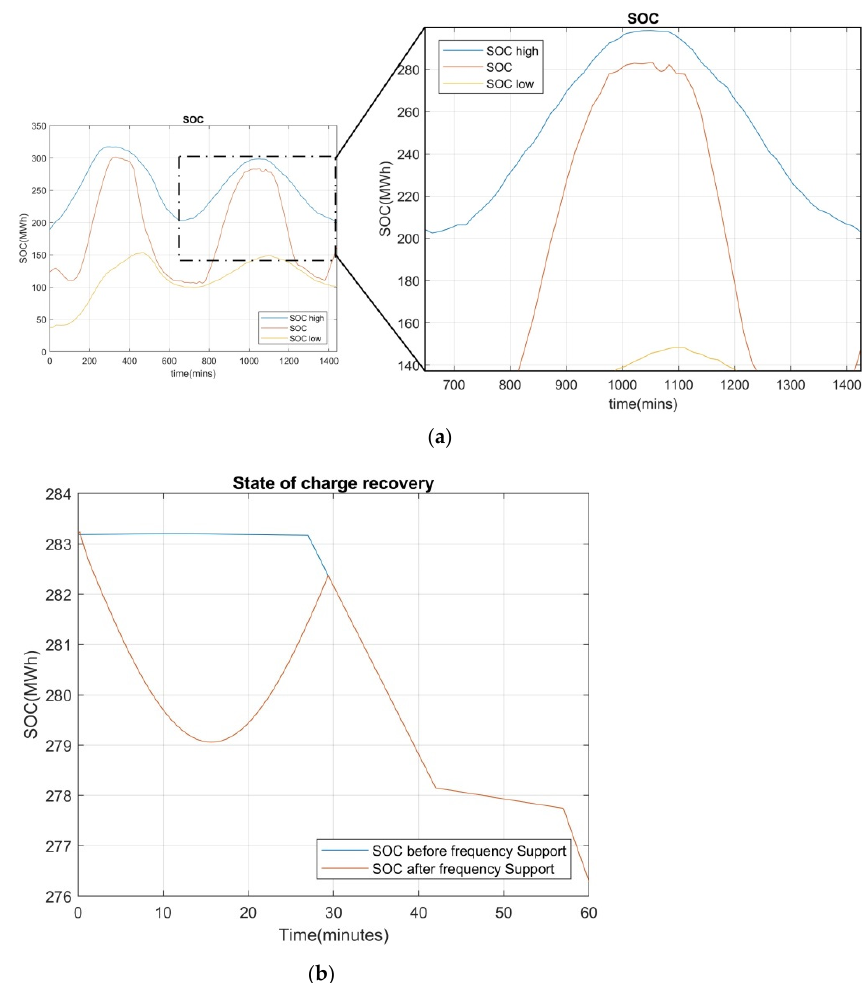
Figure 15. ( a ) SOC restored to previous values after increasing due to power absorption; ( b ) SOC trajectory before/after frequency support